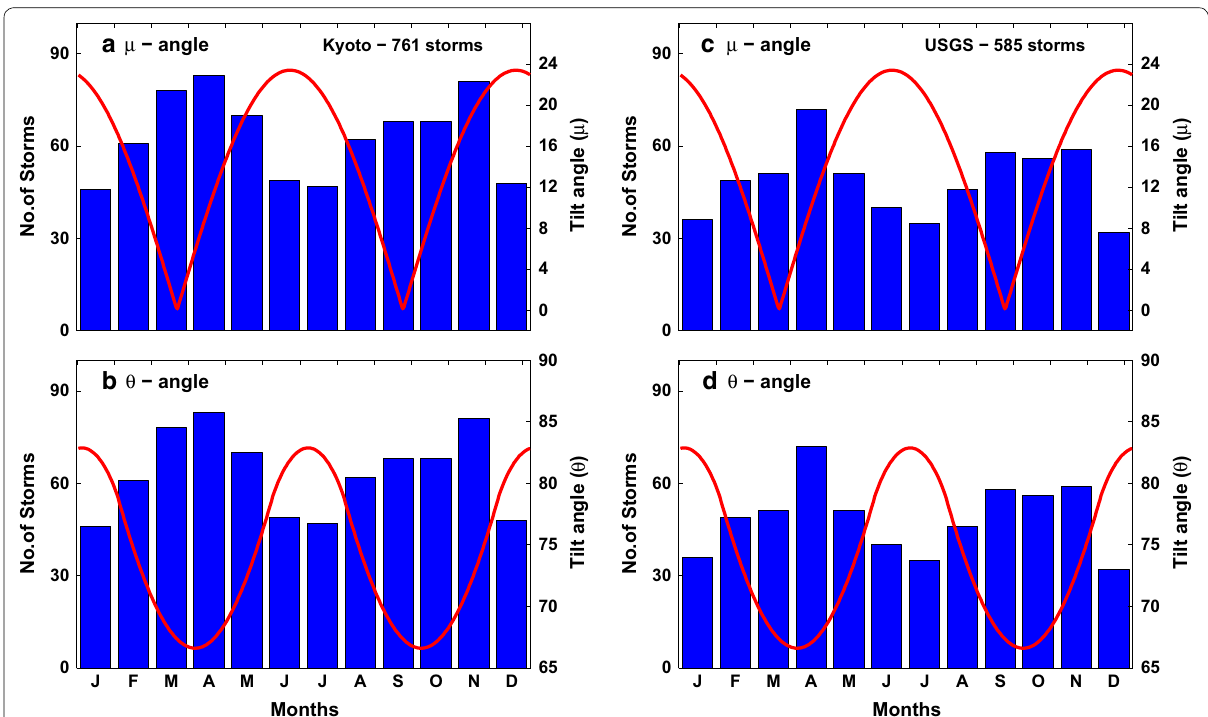
Fig. 9 Seasonal variation of daily mean Earth’s Dipole tilt angles µ ( a , c ) and θ ( b , d ) superposed with that of number of storms in Kyoto Dst and USGS